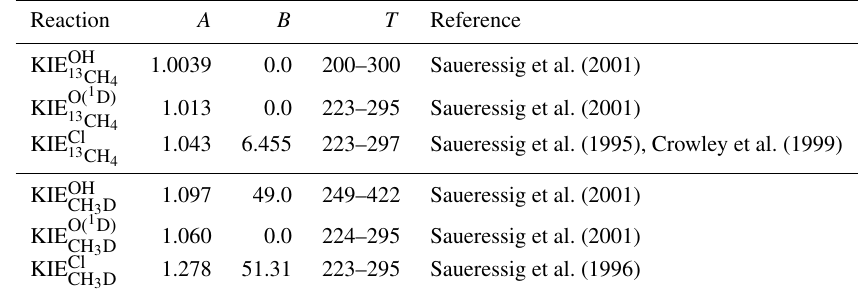
Table 1. Temperature-dependent KIEs of the sink reactions of CH 4 described as KIE = A · exp (B/T ) . The KIEs are valid in the given temperature range ( T , in